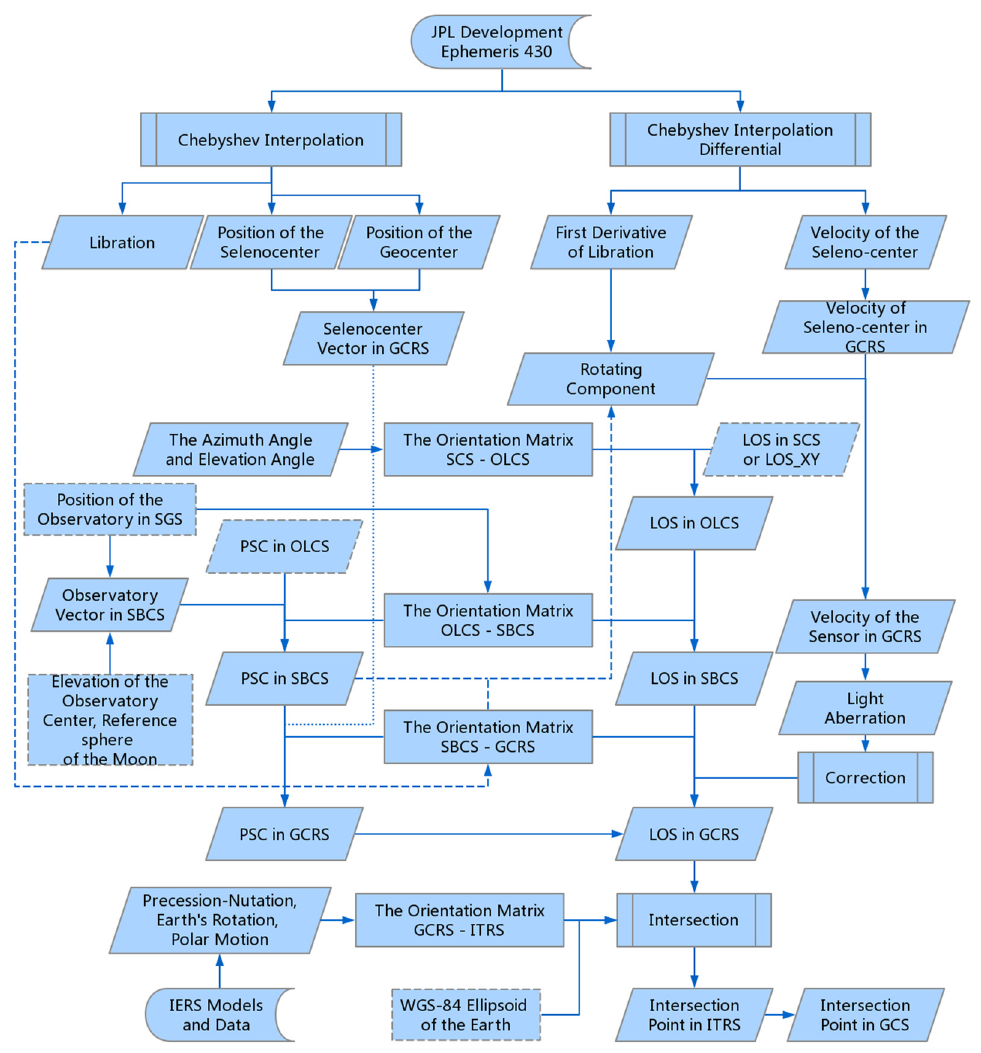
Figure 4. Simulation flow chart.